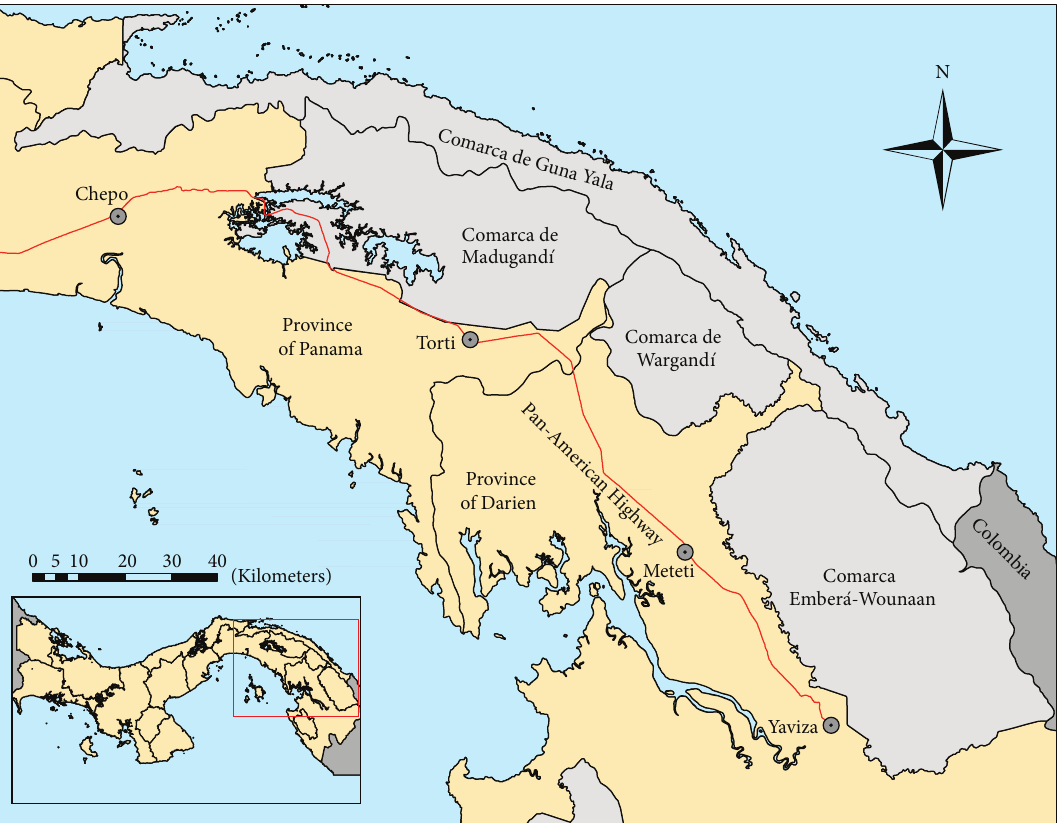
F 1: Map showing Eastern Panama, which includes the eastern part of the Province of Panama, starting in Chepo, a town that is located about 60km east of Panama City, and the Province of